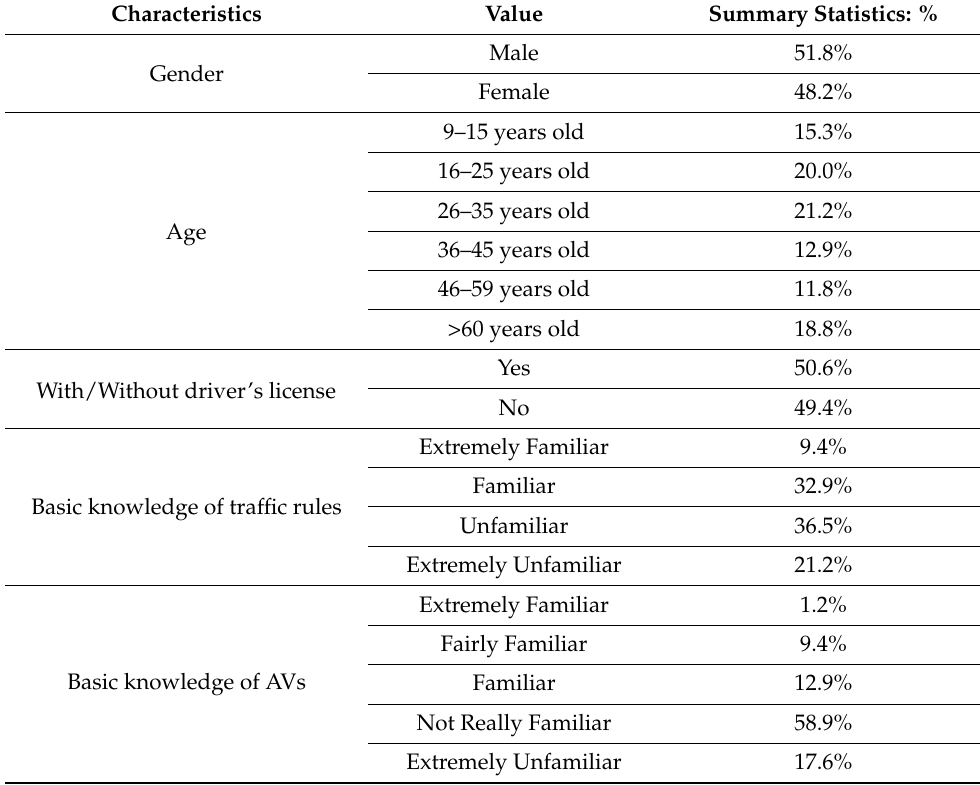
Table 2. A summary of demographic data, including gender, age, with/without driver’s license, and basic knowledge of traffic rules and